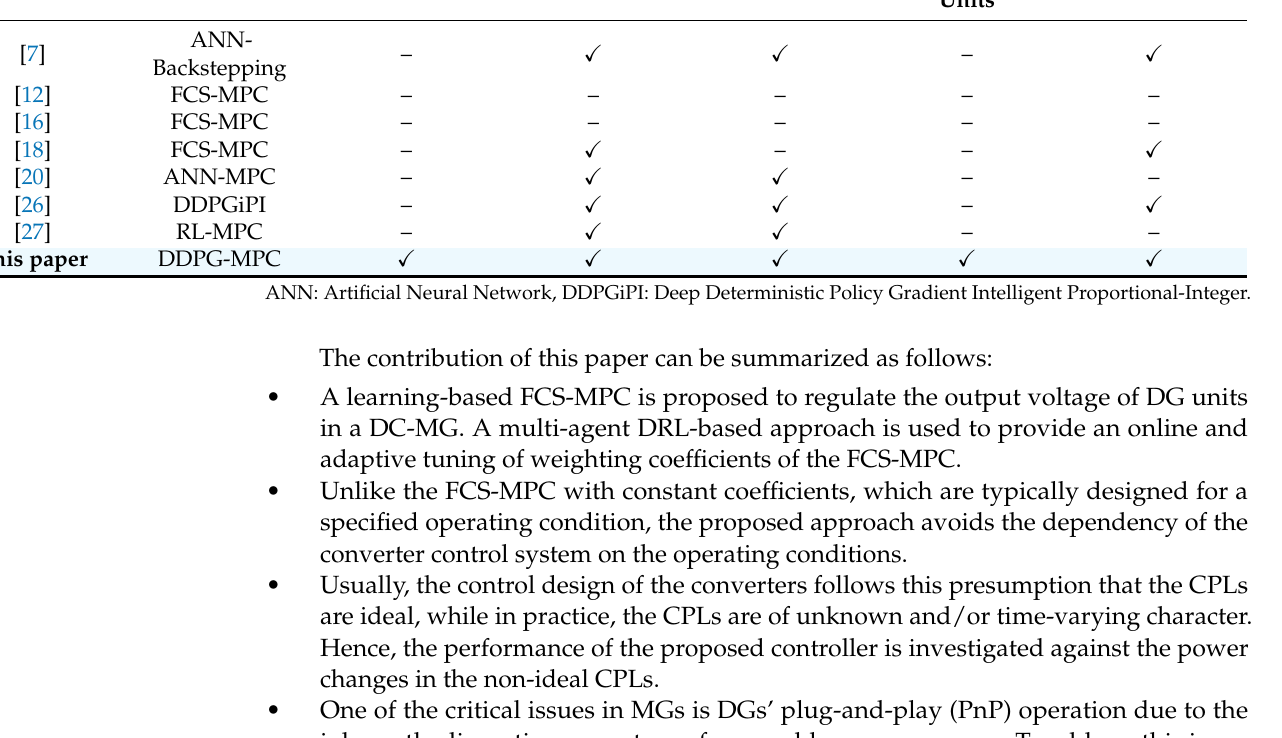
Table 1. Comparison of the contributions of this paper with the previous studies.